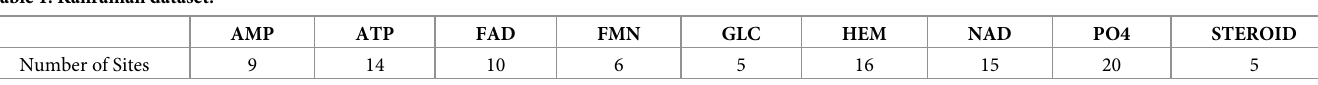
Table 1. Kahraman dataset.